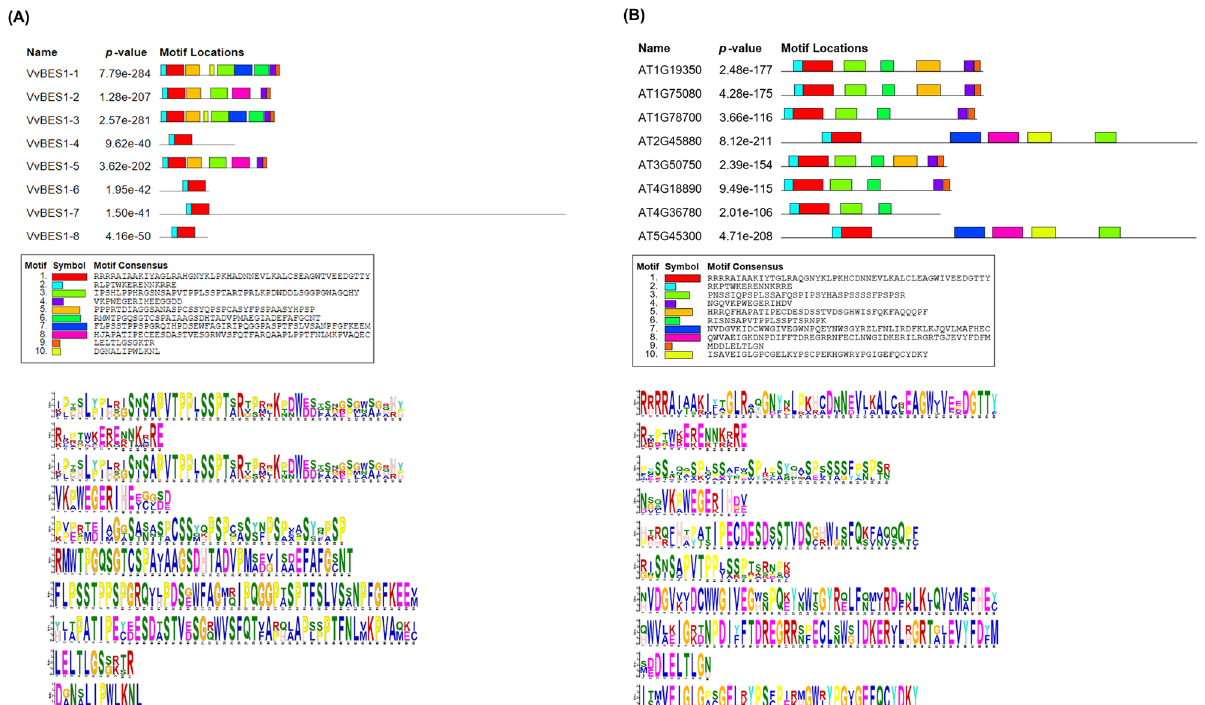
Figure 3. Identification of conserved motifs of BES1 gene family in V. vinifera and A. thaliana . ( A ) Analysis of conserved motif of BES1 amino acids in V. vinifera . ( B ) Analysis of conserved motif of BES1 amino acid in A. thaliana . Different boxes describe different conserved motifs. The same conserved motifs are indicated by same color. The representative motifs of VvBES1 and ATBES1 are displayed below the motif graph in the form of